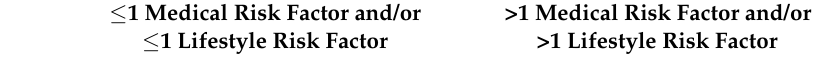
Table 1. Sampling